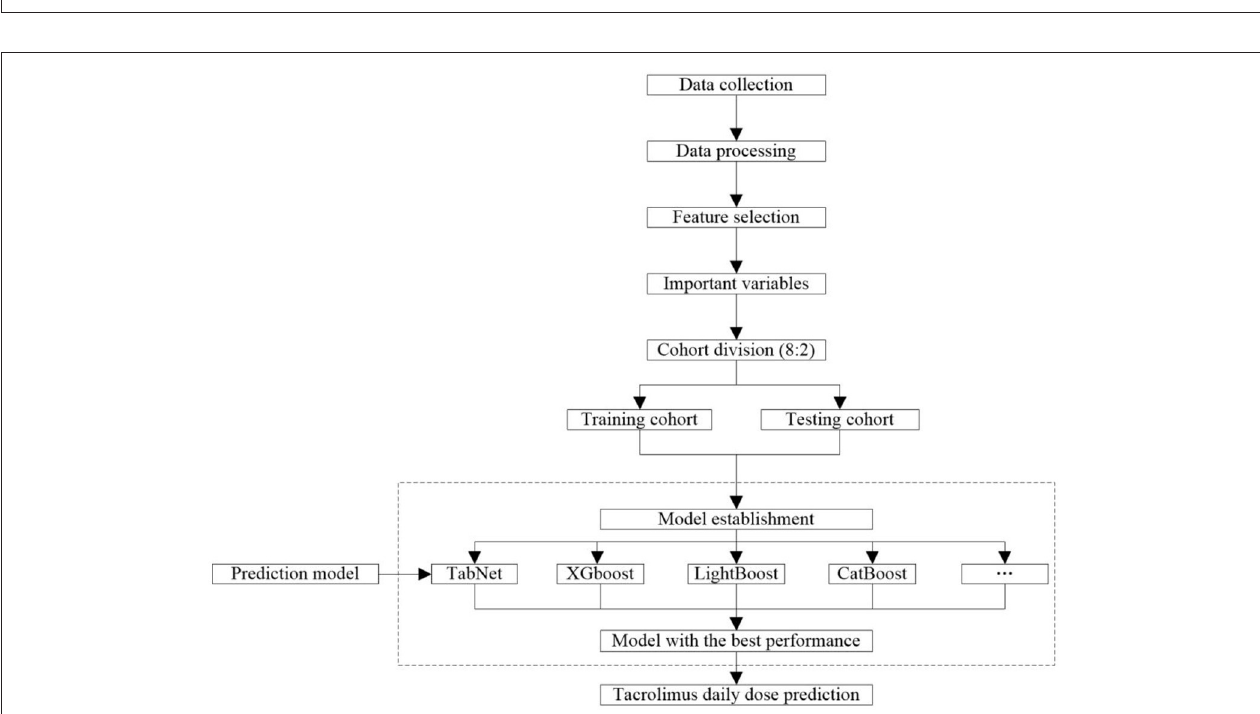
FIGURE 1 | Enrollment of patients.